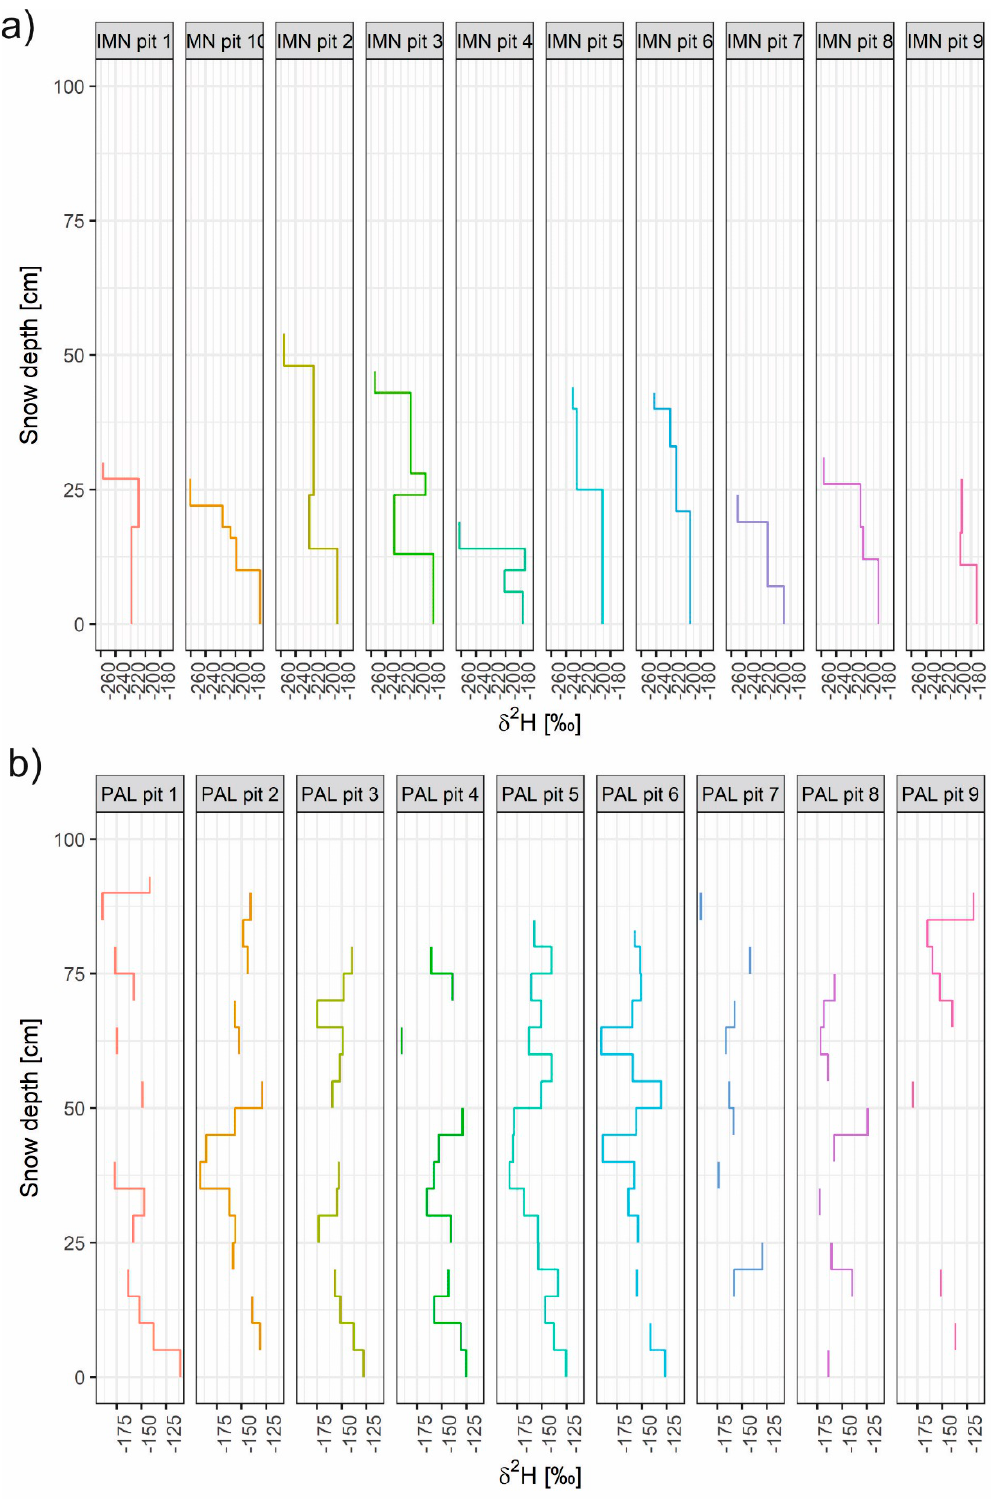
Figure A5. δ 2 H profiles for individual snowpits at ( a ) Imnavait and ( b ) Pallas. Zero on the y-axis represents the base of the snowpack.